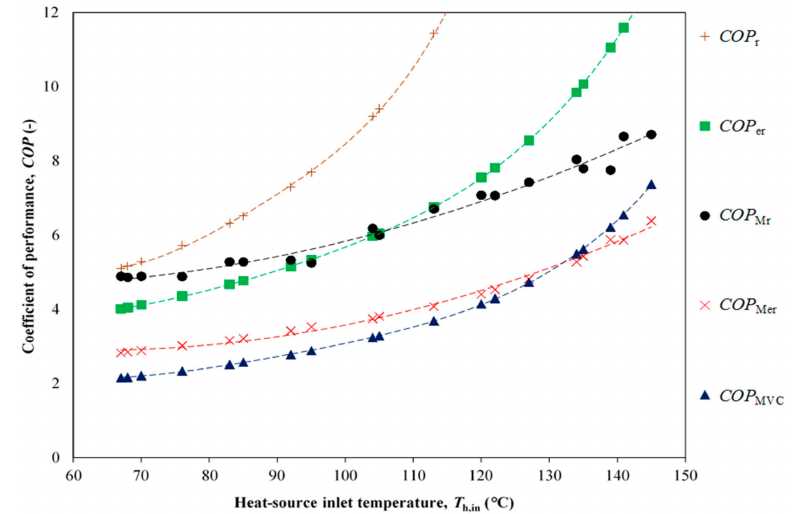
Figure 9. Predictions of MVC heat pump COPs from the empirical model (Equation (20)) and theoretical COP models as a function of the heat-source inlet temperature (from 65 to 145 ◦ C), when utilizing the thermal energy from the streams listed in Table 5 with the heat sink at 150 ◦ C (low pressure (LP)